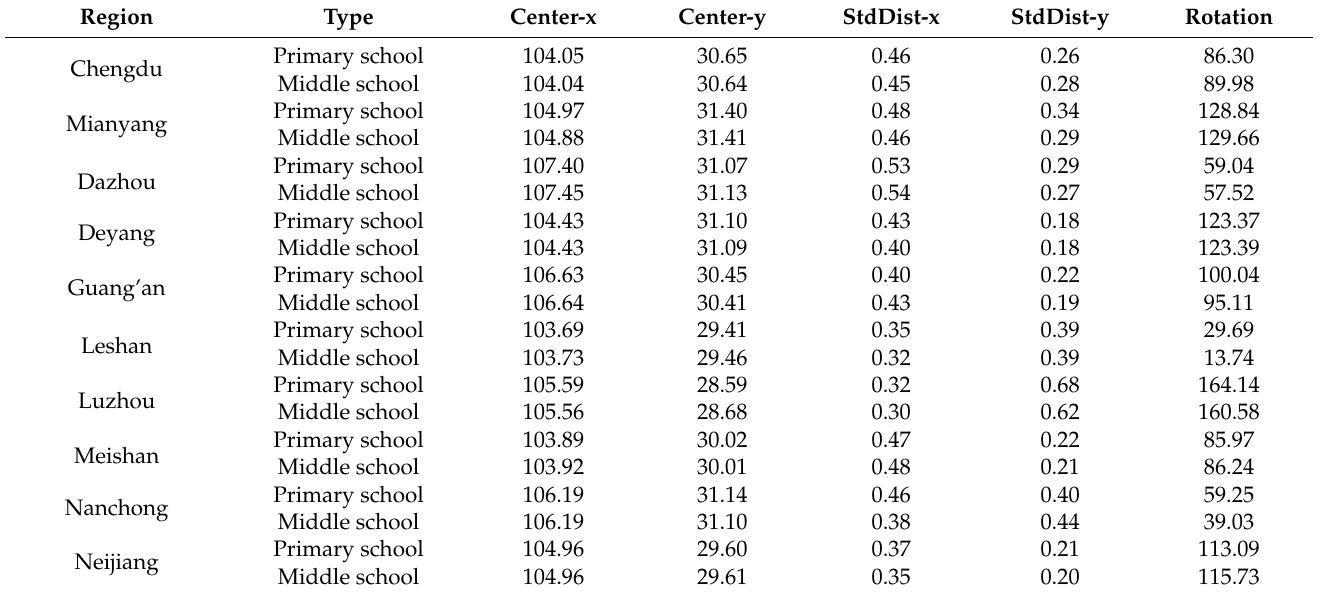
Table A1. The parameters of SDE in 38 basic